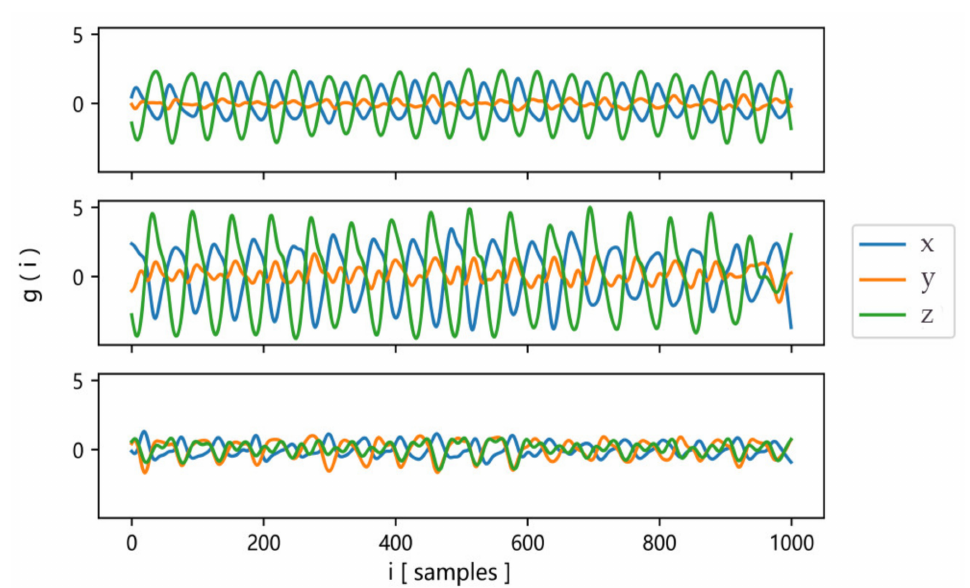
Figure 5. Comparison of gyroscope signals from three randomly selected volunteers.